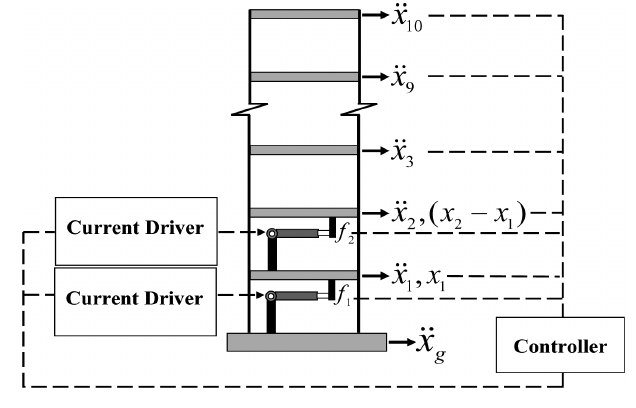
Fig. 1. Ten storey building with MR dampers and feedback